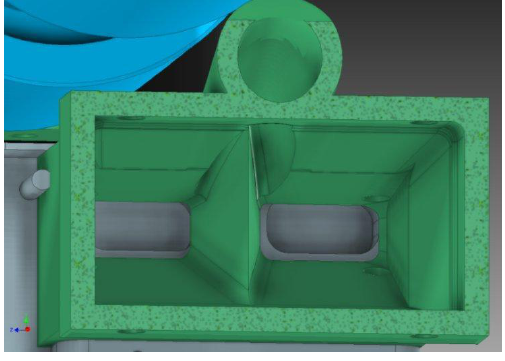
Figure 5. Designed mixing